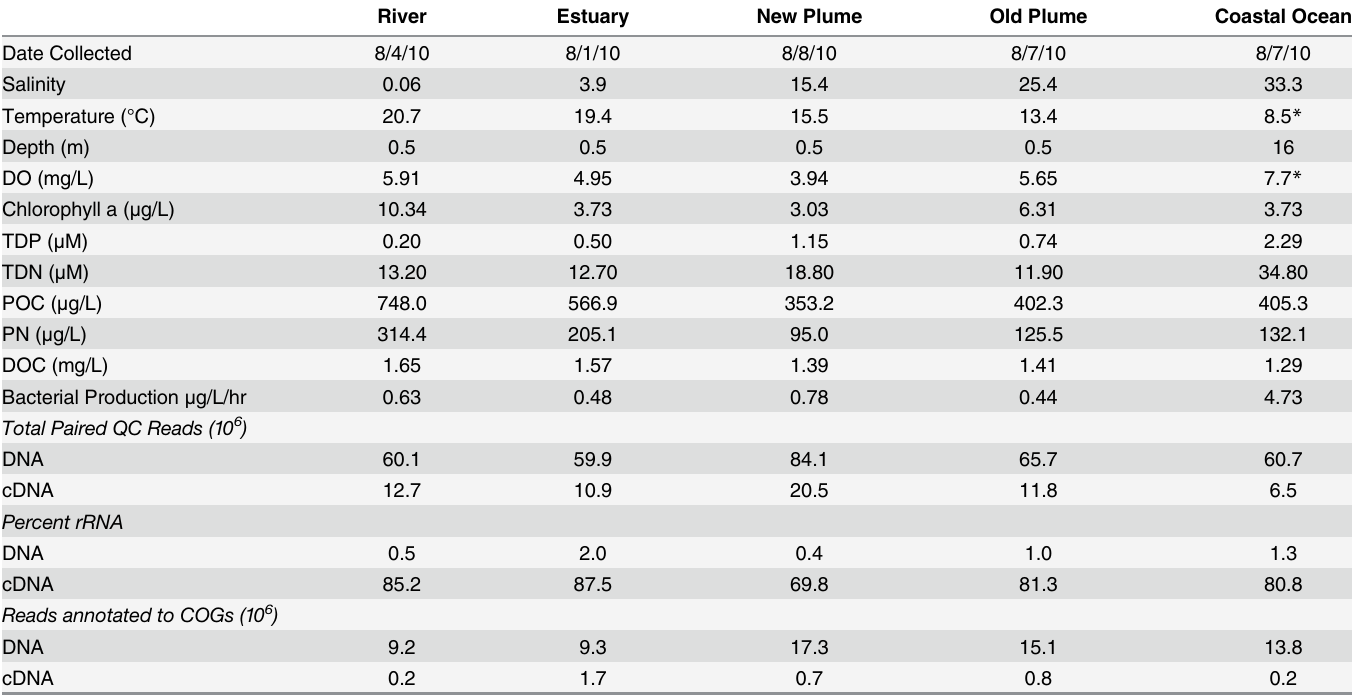
Table 1. Sample environmental data and sequencing